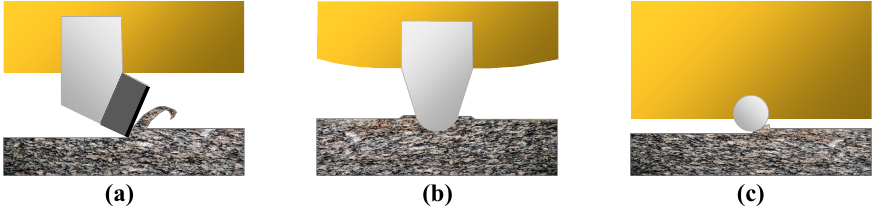
Figure 1. Cutting mechanics of various bit types: ( a ) PDC cutter; ( b ) roller cone; ( c ) natural diamond (modified based on [33]).